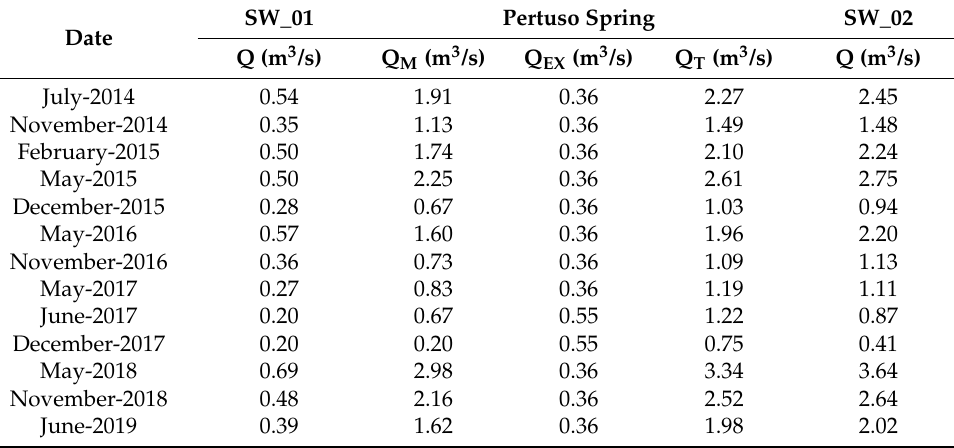
Table 2. Discharge values measured by traditional current-meter method at SW monitoring points (Q), at Pertuso Spring cross section (Q M ) and exploited rates (Q EX ). The sum of Q M and Q EX is the total spring discharge Q T .